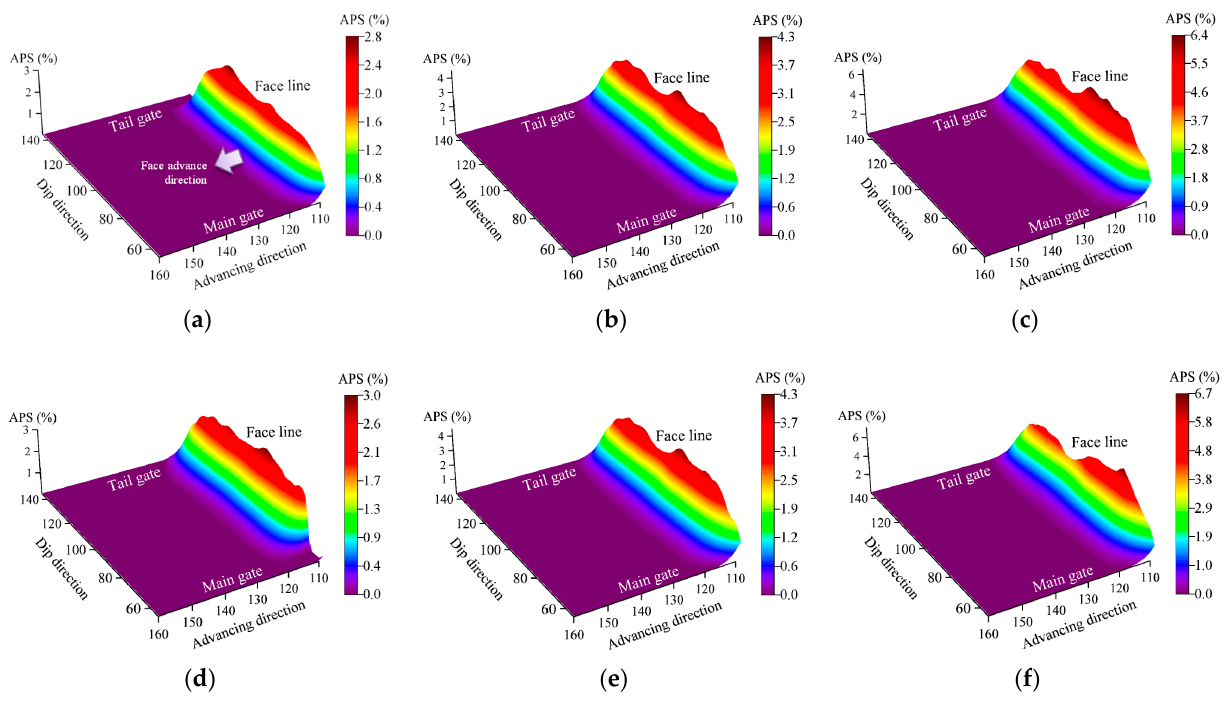
Figure 18. Influence of pre ‐ existing fractures on APS of top ‐ coal. ( a ) Model I; ( b ) Model II; ( c ) Model III; ( d ) Model IV; ( e ) Model V; ( f ) Model VI.